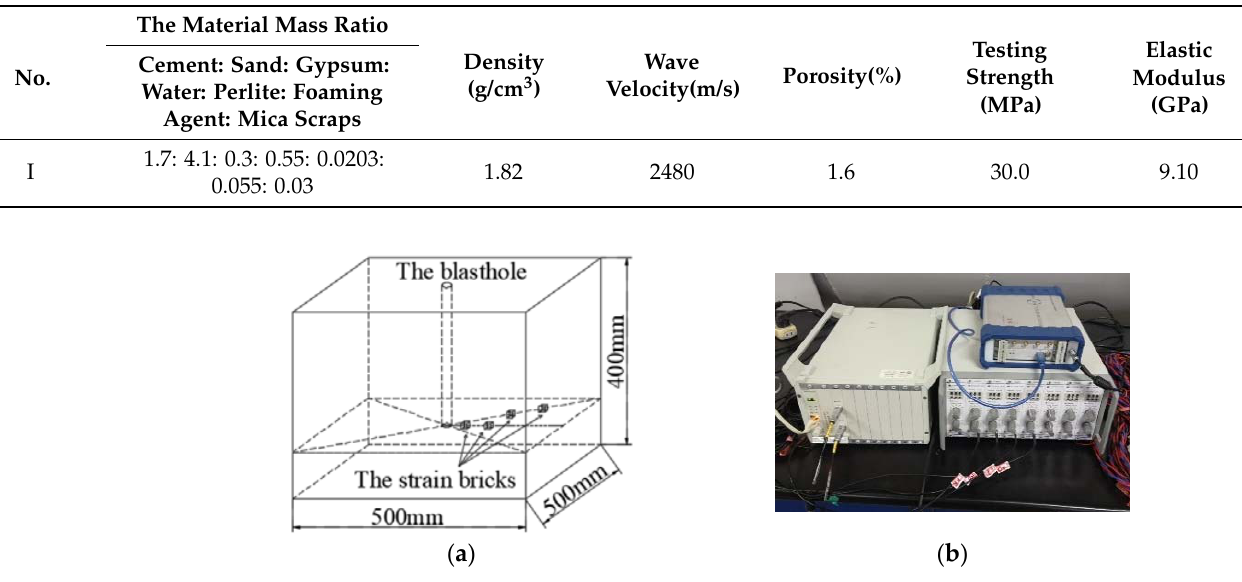
Figure 13. Experimental instrument and monitoring point: ( a ) layout of measuring points; ( b ) DH5922N dynamic signal acquisition system. Table 4. The material mass ratio and physico ‐ mechanical parameters of the sample.